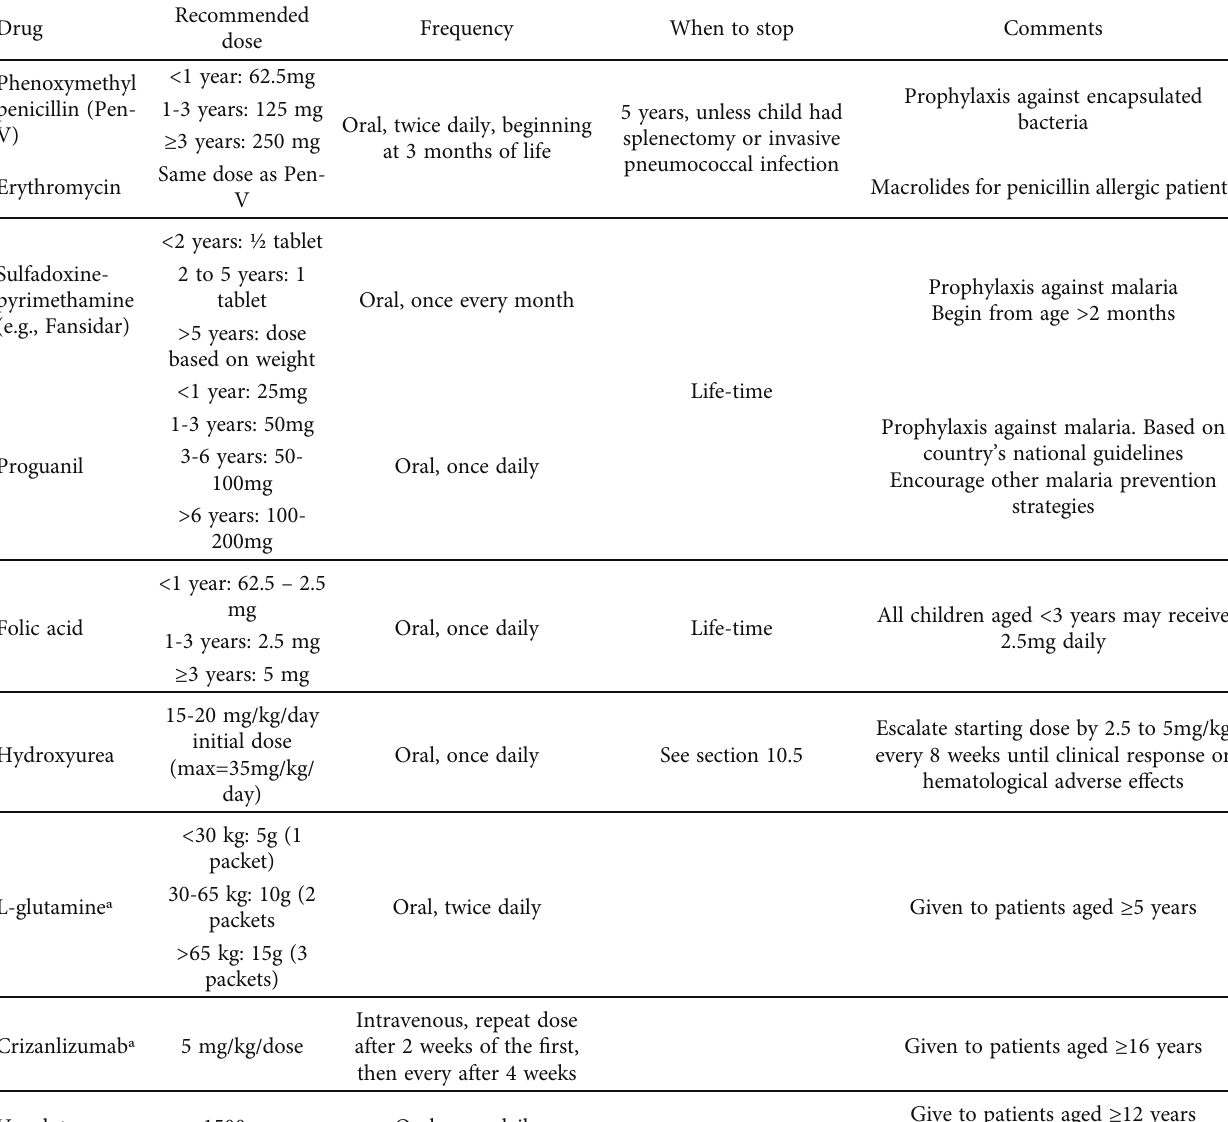
Table 2: Drugs used in sickle cell